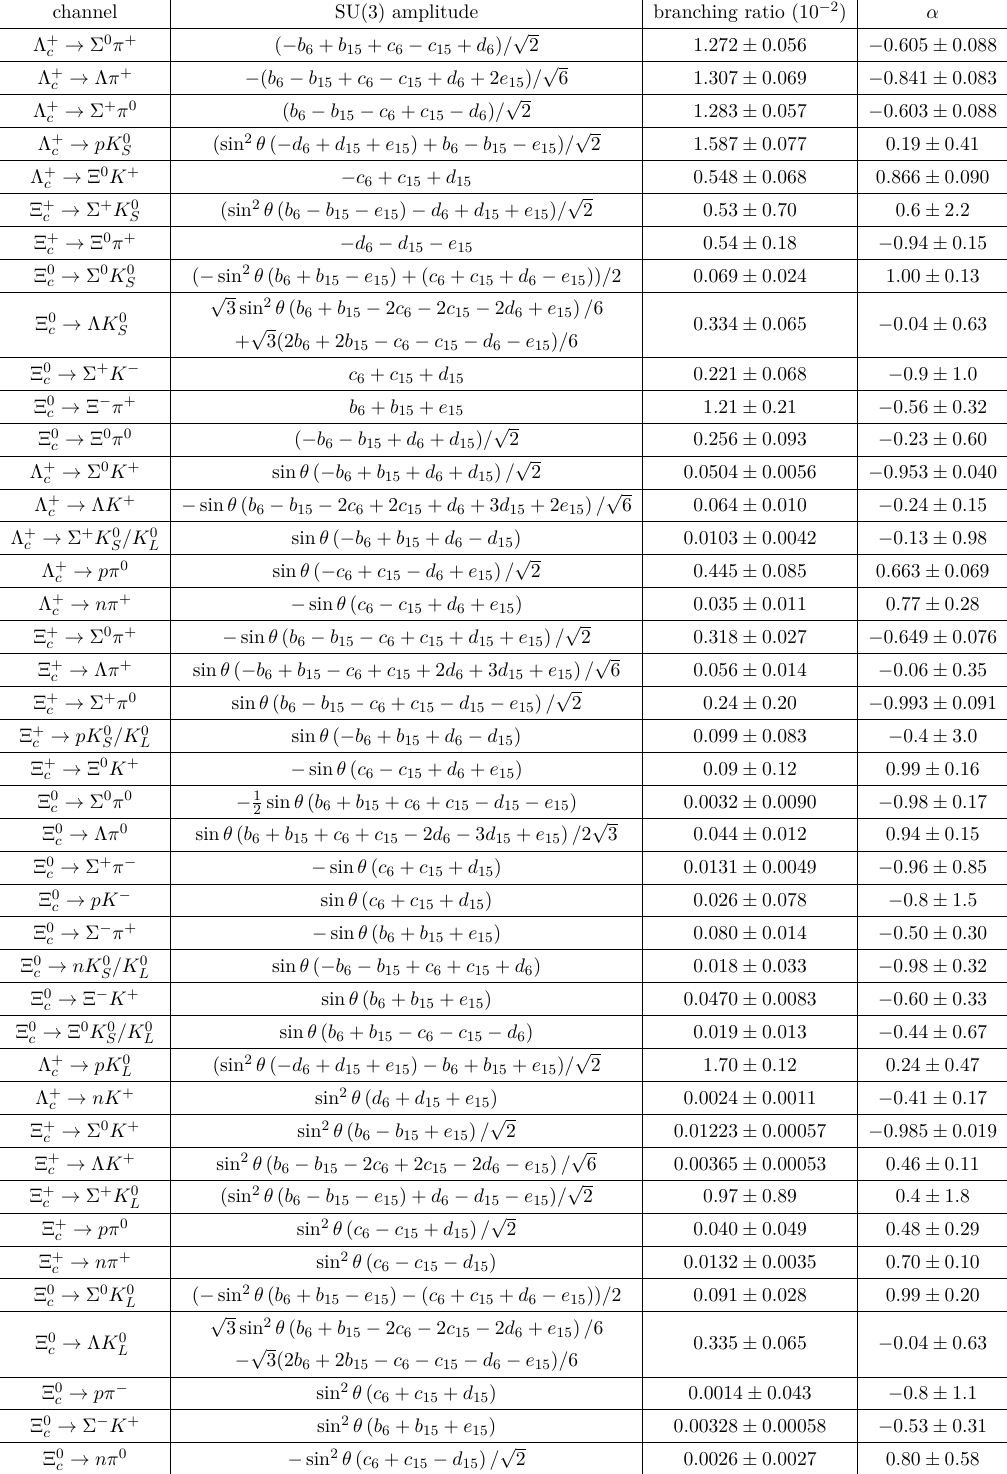
Table 1 . SU(3) amplitudes and predicted branching fractions (the third column) and polarization parameters (the fourth column) of anti-triplet charmed baryons decays into an octet baryon and an octet